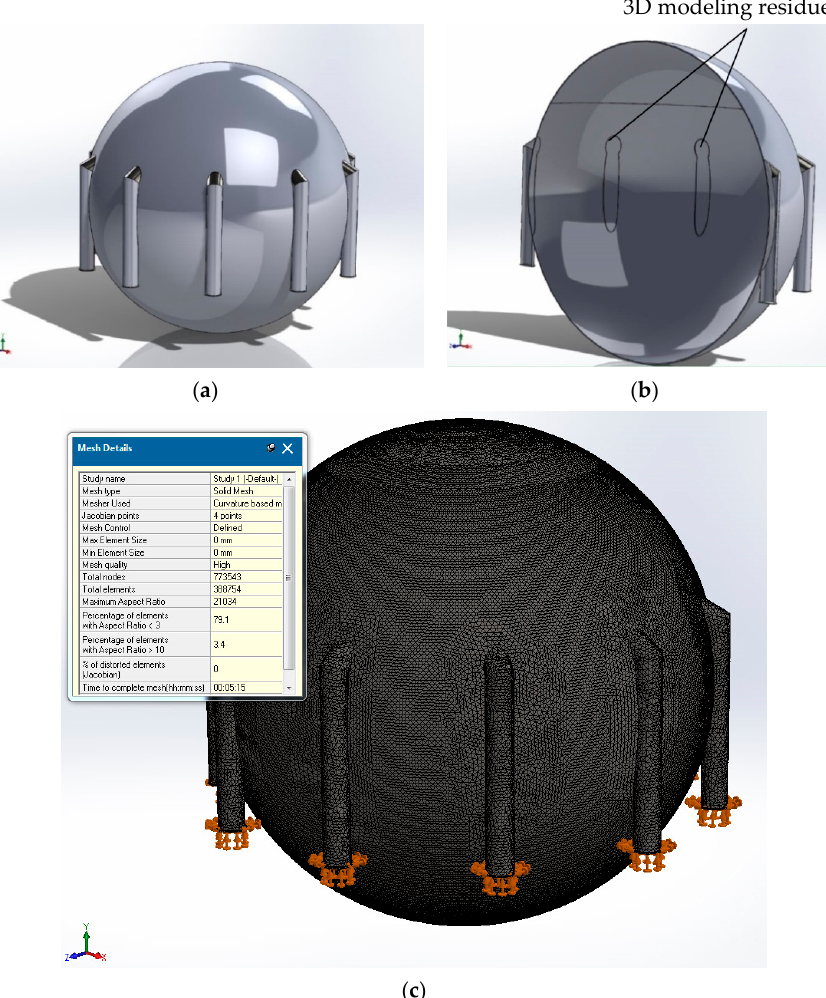
Figure 1. 3D model of full “part” option simulation parameters: ( a ) tank simulation model using the “part” option, ( b ) tank simulation modeling issues using the “part” option, and ( c ) 3D modeling using the unique study element finite element method (FEM) meshing with 388,754 elements for a single full part case.